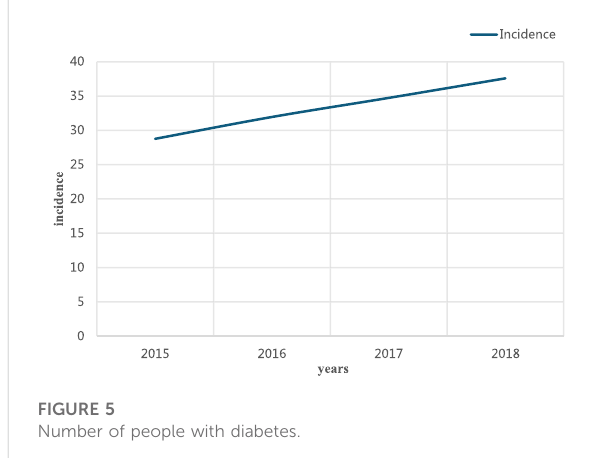
FIGURE 4 Age structure of diabetes.